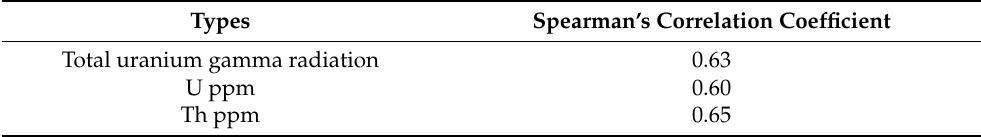
Table 6. Correlations between thermal anomalies and radioactive elements.